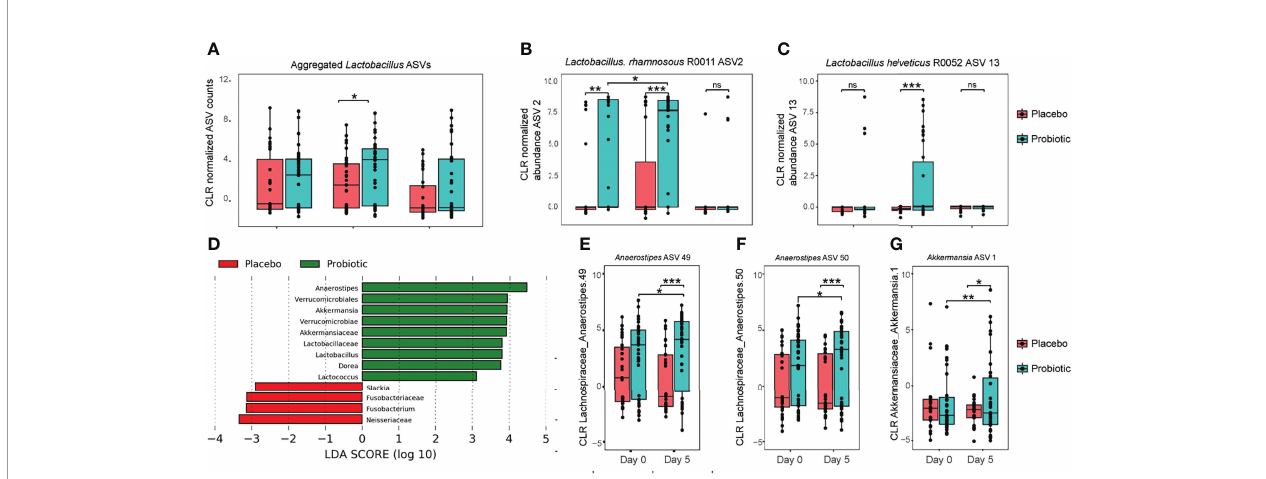
FIGURE 1 | Genus level bacteria taxa during treatment with probiotics. (A) Center log ratio normalized abundance of ASV aggregated to Lactobacillus at the genus level; (B) center log ratio normalized abundance for Lactobacillus ASV2; and (C) centre log ratio normalized abundance for Lactobacillus ASV13. (D) Linear discriminant analysis effect size (LEfSe) analysis identi fi ed the most differentially abundant taxa between probiotic and placebo measured at study day 5; (E – G ) using linear mix model regression, center log ratios with normalized abundance of individual amplicon sequence variants (ASV) were signi fi cantly associated with both probiotic intervention and changes across time. Levels of Akkermansia increased between study day 0 and day 5 in participants randomly assigned to the probiotic treatment study group. Signi fi cance was assessed using linear mixed modeling, pairwise comparisons were performed using estimated marginal means, with Tukey ’ s multiple comparison testing. Signi fi cance is denoted as *P < 0.05, **P < 0.01, ***P < 0.001 versus placebo; NS denotes not statistically signi fi